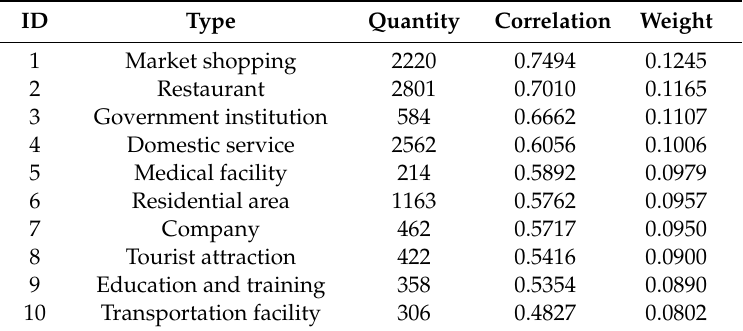
Table 1. Correlation between POIs and the population grid.